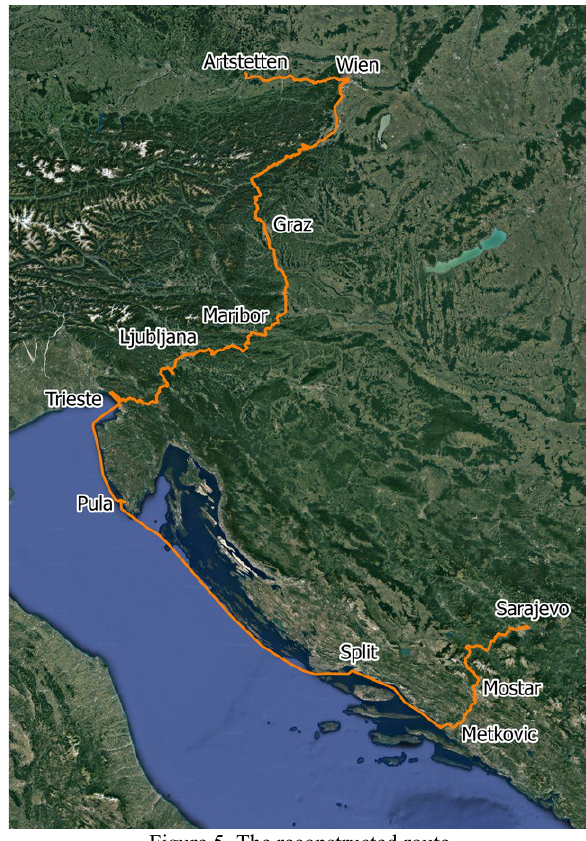
Figure 5. The reconstructed